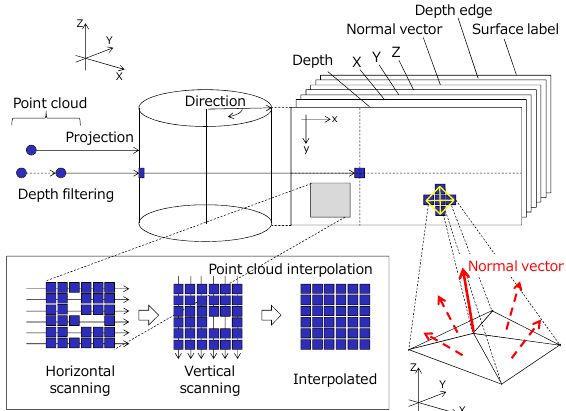
Figure 3. Point-based